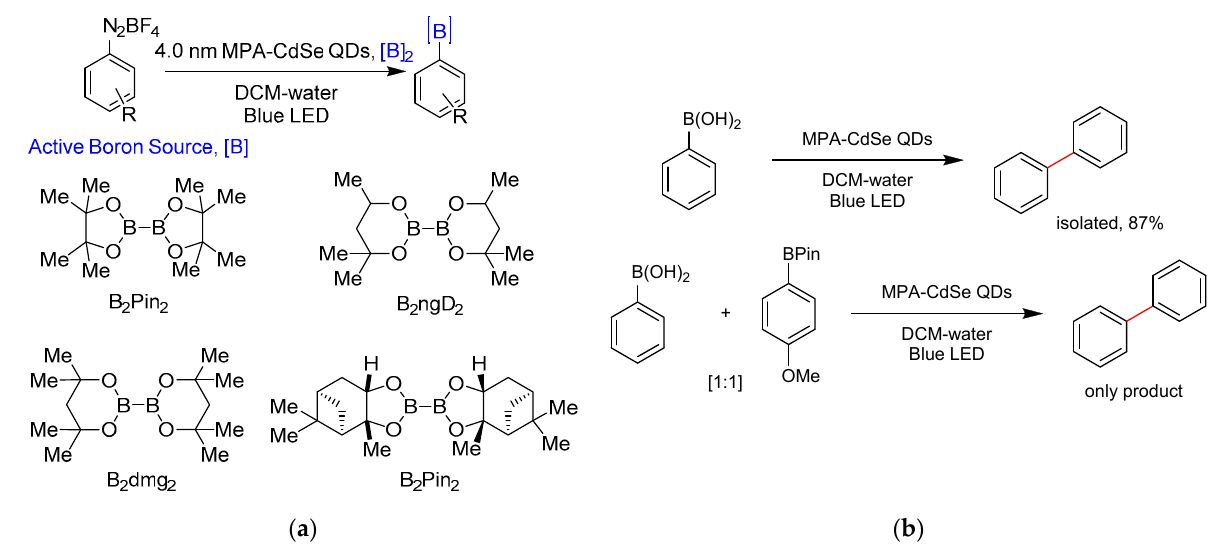
Scheme 11. ( a ) The photocatalytic borylation of diazonium salts using MPA-capped CdSe QDs in water; ( b ) MPA-CdSe QDs catalyze the coupling of borylation.